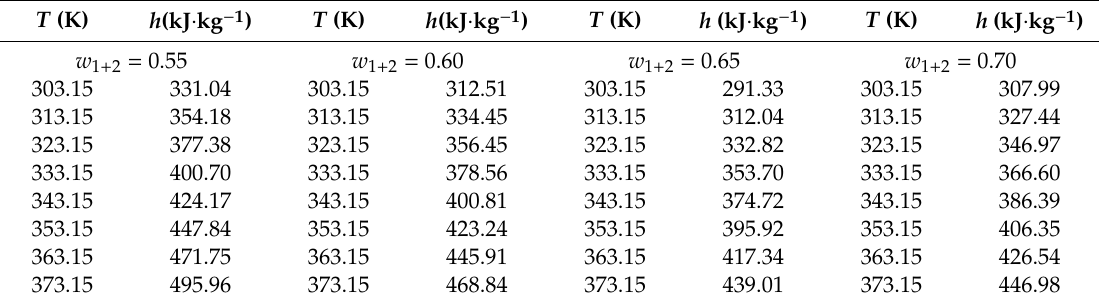
Table A11. Specific enthalpy h at absorbent mass fraction w of the system LiBr (1) + [BMIM]Cl (2) + H 2 O (3) at p = 0.1 MPa a .